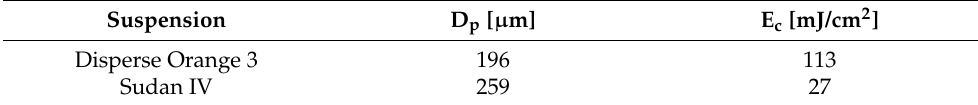
Figure 18. Jacobs working curve for lithium disilicate suspensions prepared by using a 3:1-mixture of BBP and DBP and either Sudan IV or Disperse Orange 3 as absorber. Table 7. Penetration depth and critical polymerization energy, calculated from Figure 18 .